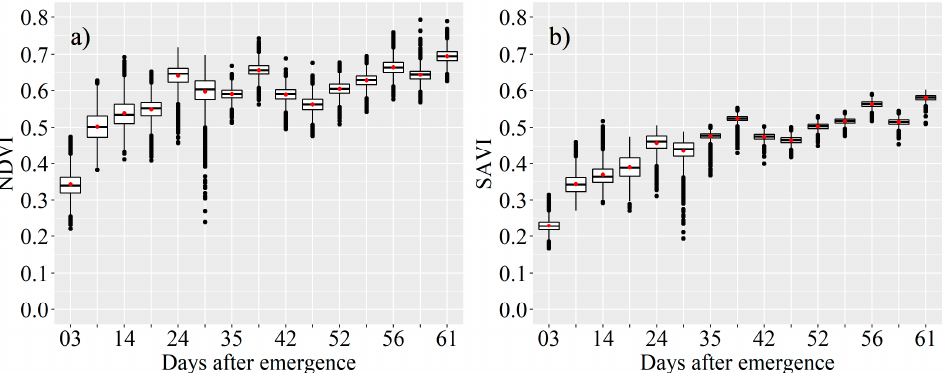
Figure 3. Descriptive statistics of the temporal and spatial variability of maize crops by Normalized Difference Vegetation Index (NDVI) ( a ) and Soil-Adjusted Vegetation Index (SAVI) ( b ).